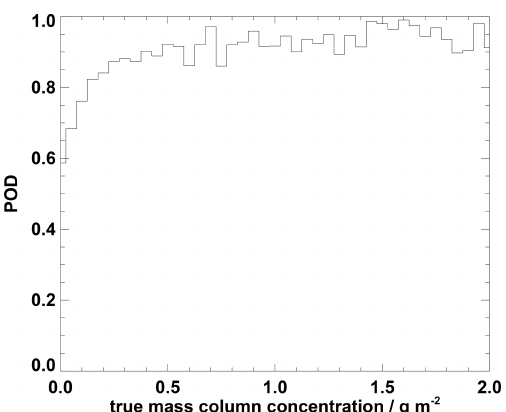
Figure 4. Two-dimensional histogram of ash layer properties used as input for the calculation of the simulated validation data set.